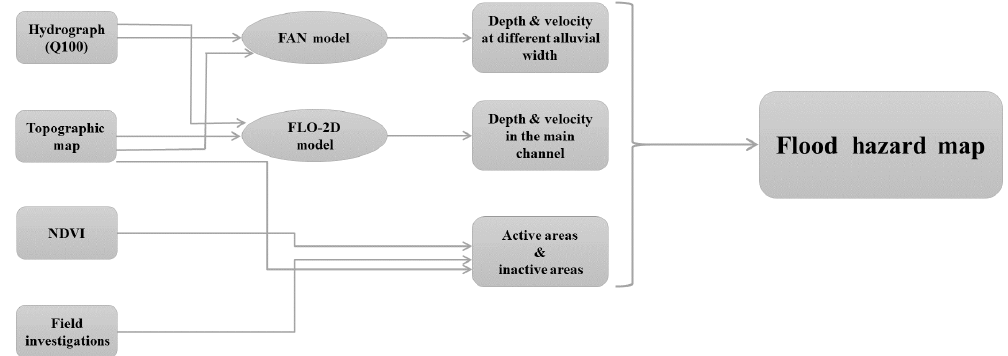
Figure 1. The flow chart proposed for creating the flood hazard map.